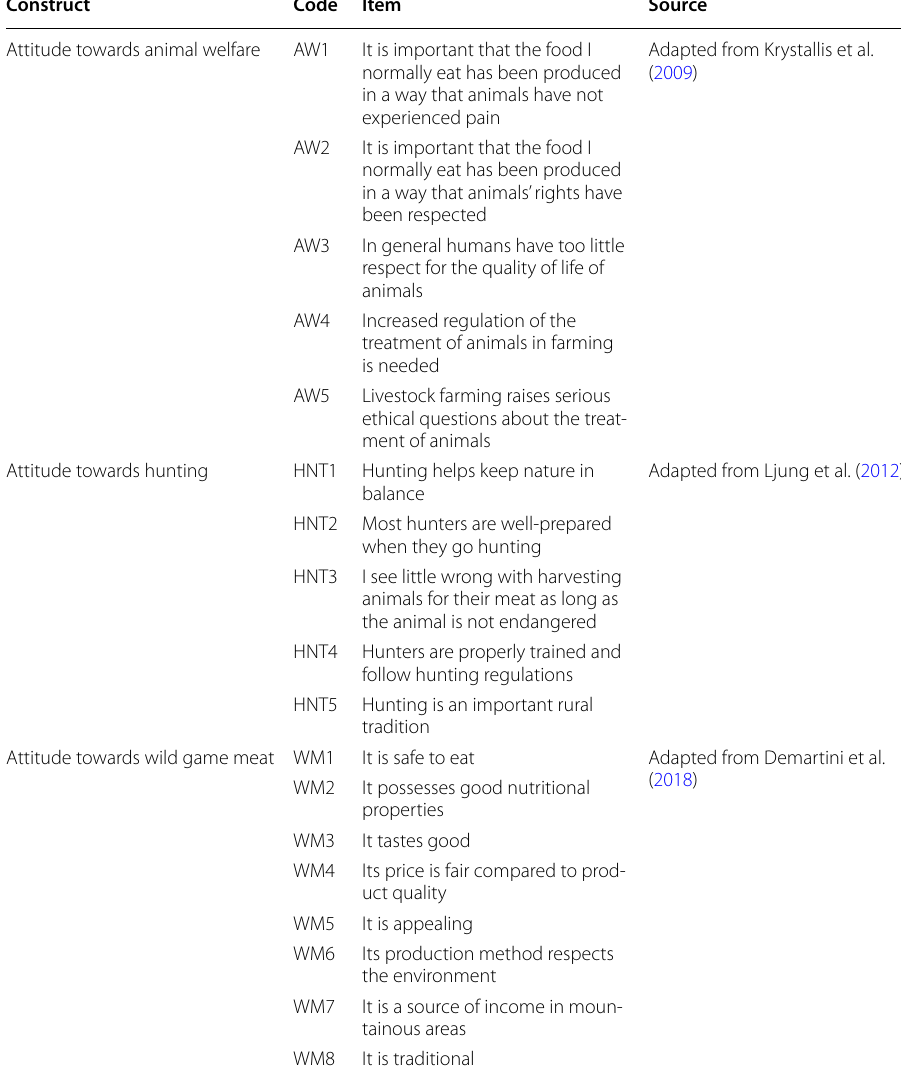
Table 3 Items to observe the attitudes towards animal welfare, hunting, and wild game Construct